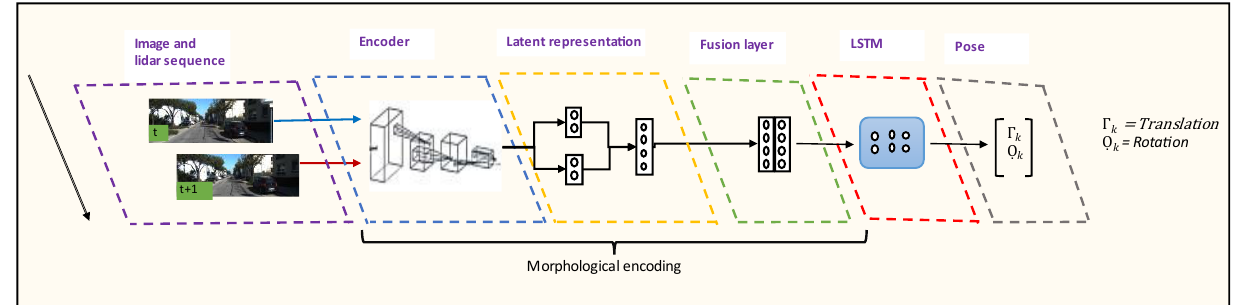
Figure 6. Proposed mono camera odometry architecture.